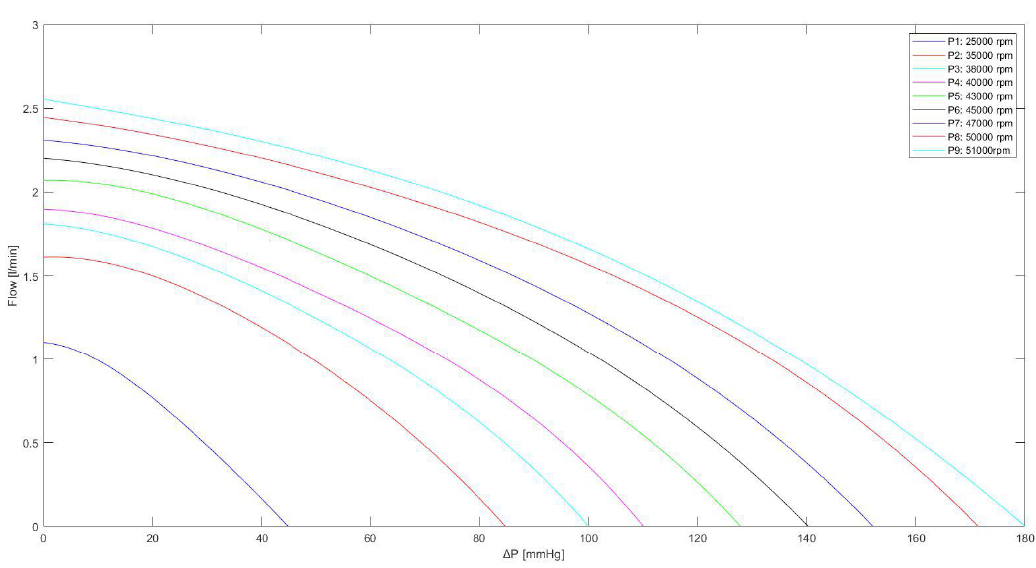
Figure 4. Relationship between the flow through the Impella 2.5 pump and the pressure difference for different rotational speeds. The curves were obtained using Equation (3), with the values listed in Table 1.